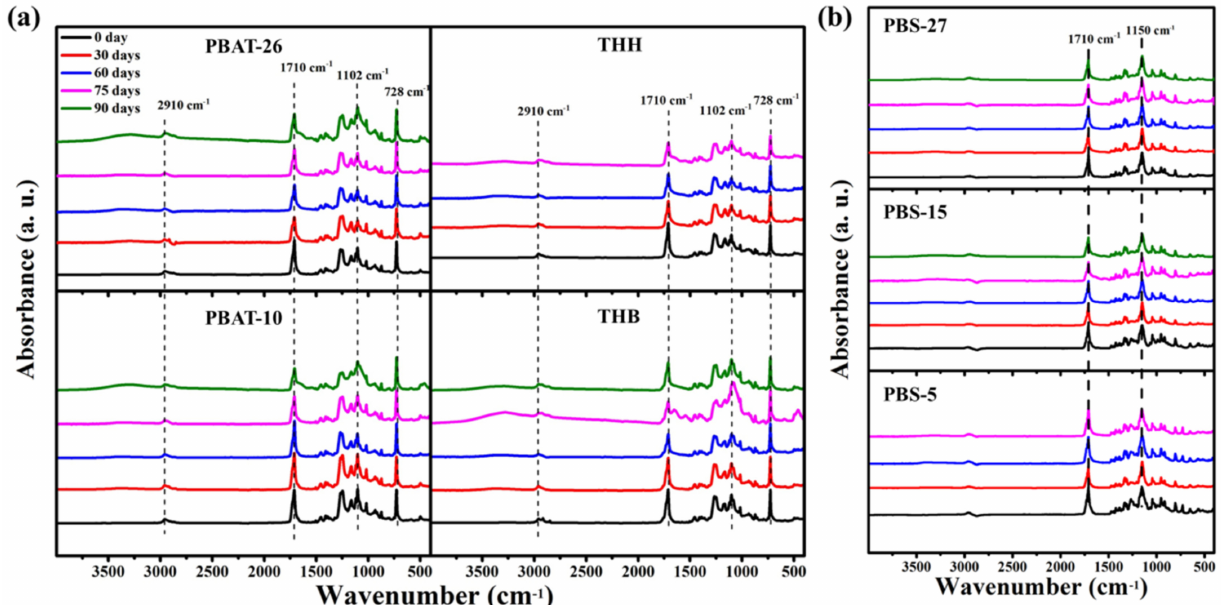
Figure 4. The FTIR spectra of ( a ) PBAT and ( b ) PBS mulching films before and after degradation. Due to the addition of inorganic fillers, the characteristic peaks of CaCO 3 and carbon black appear, while the more significant decrease of the relative peak intensity of ester around 1710 cm − 1 emerges. This indicates the increased degradation rate caused by the existence of inorganic fillers, which introduced a plentiful supply of imperfect two-phase interface that can be attacked and hydrolyzed by microorganisms and hydrolytic